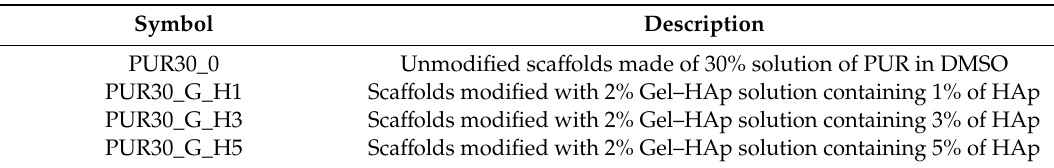
Table 1. Symbols and descriptions of obtained sca ff olds. HAp: hydroxyapatite, PUR: